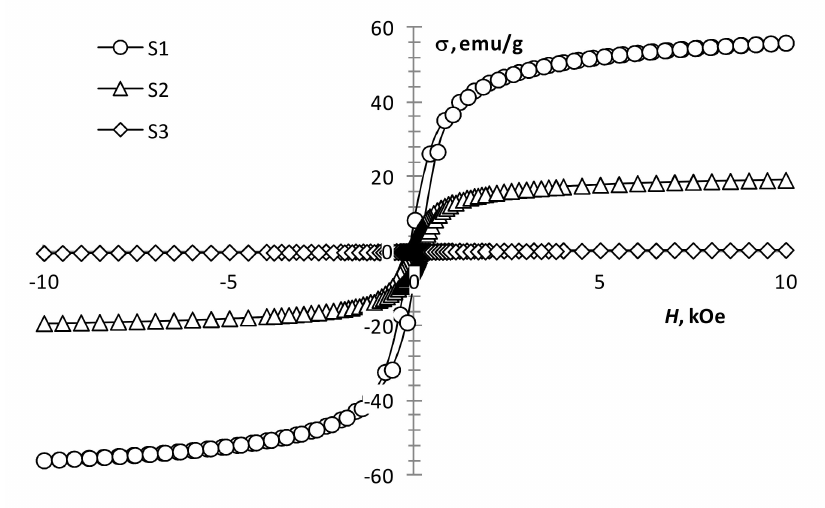
Figure 4. Magnetization loops of samples S1, S2,